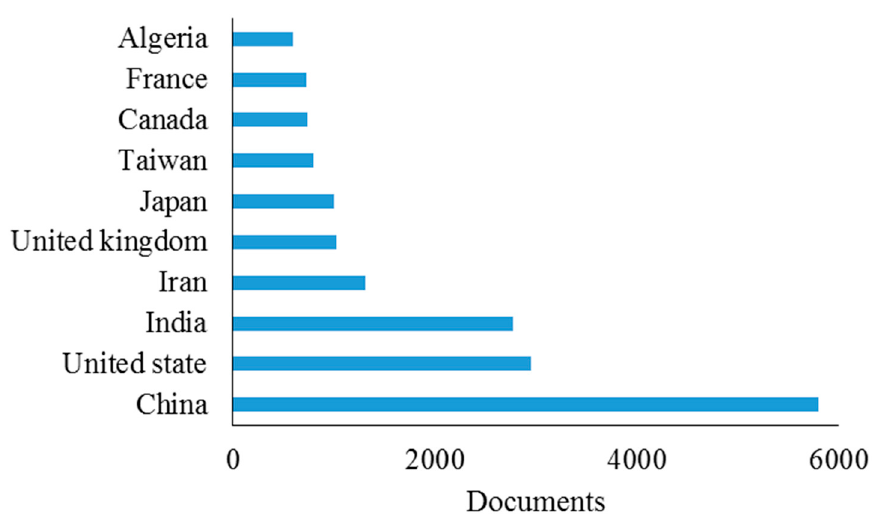
Figure 5. Analysis of the literature by based on countries (Source: Scopus & Web of Science).